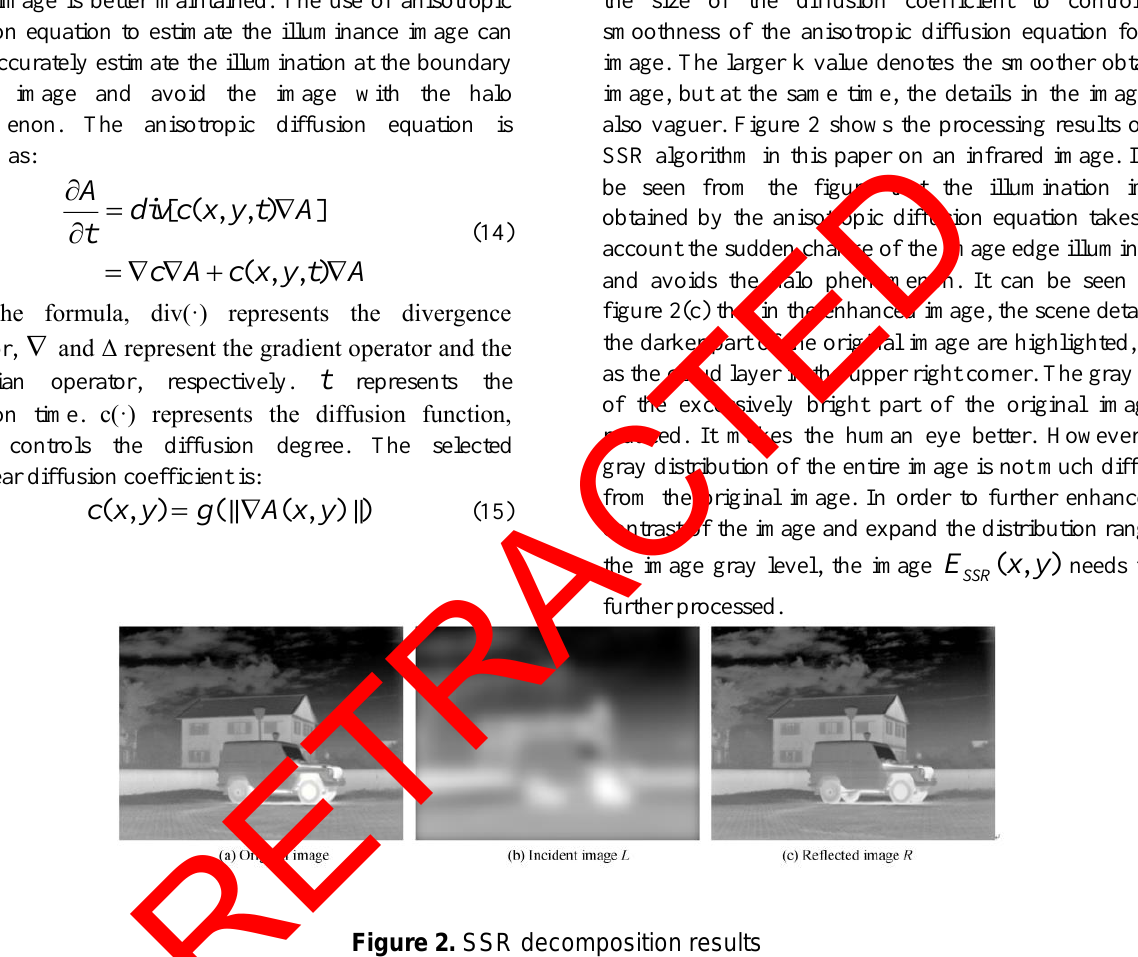
Figure 2. SSR decomposition